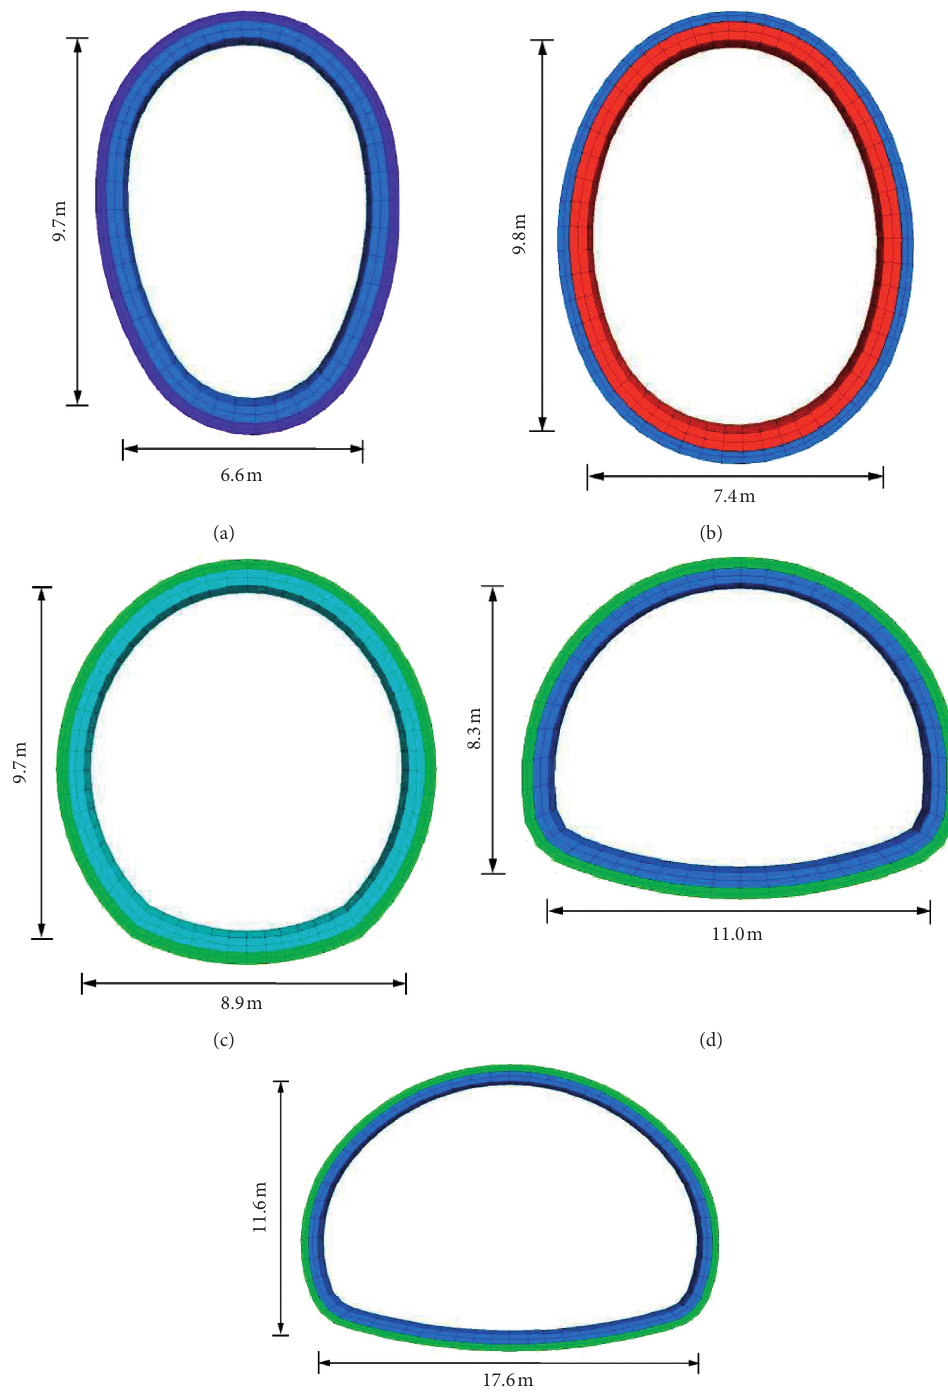
Figure 1: Cross sections in different ratios of width to height. (a) 0.68; (b) 0.76; (c) 0.92; (d) 1.33; (e)